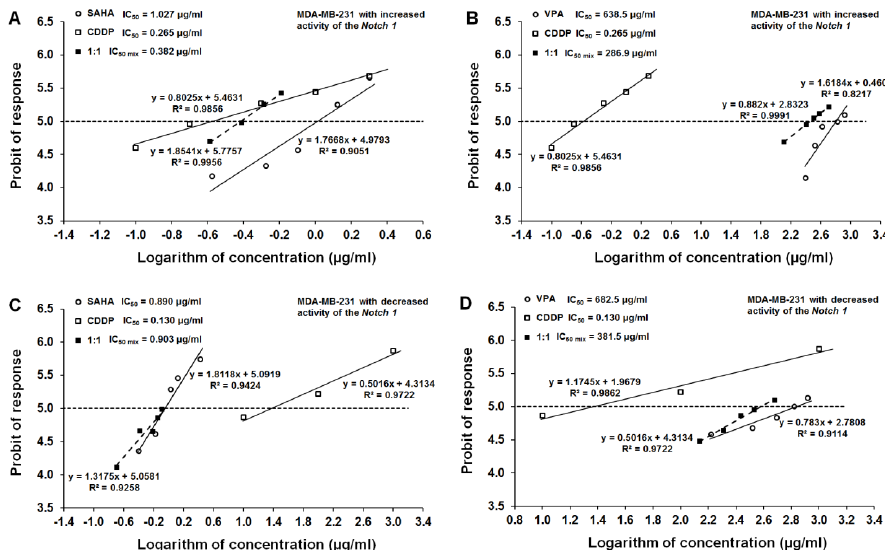
Figure 5. Log-probit dose-response relationship lines for HDIs and CDDP in transfected